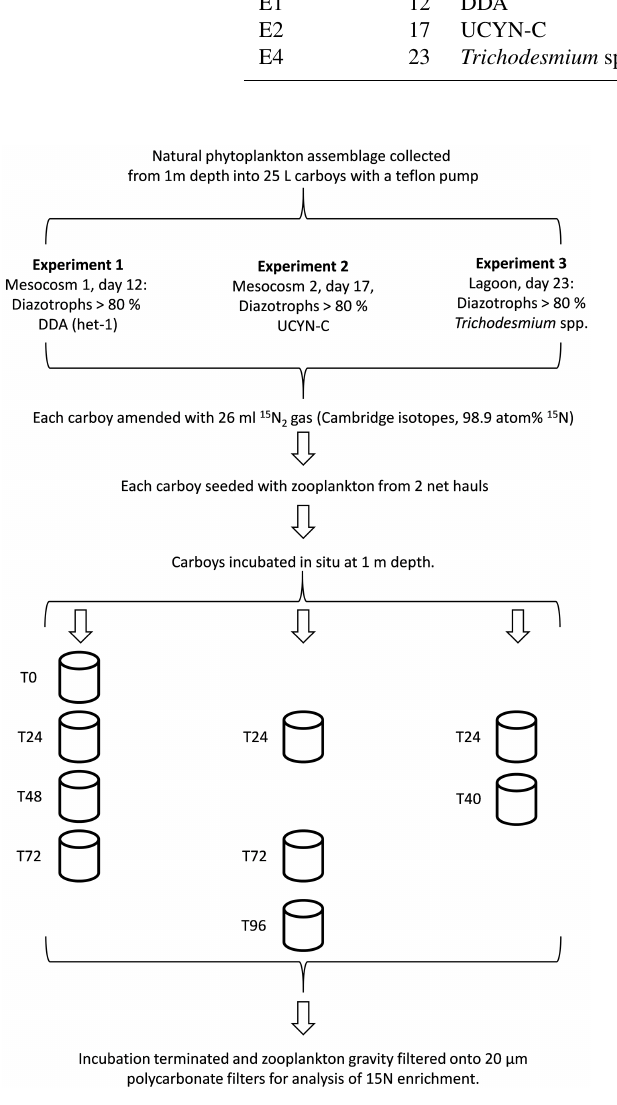
Figure 1. Schematic of field 15 N 2 incubations to measure zooplank- ton uptake and incorporation of diazotroph